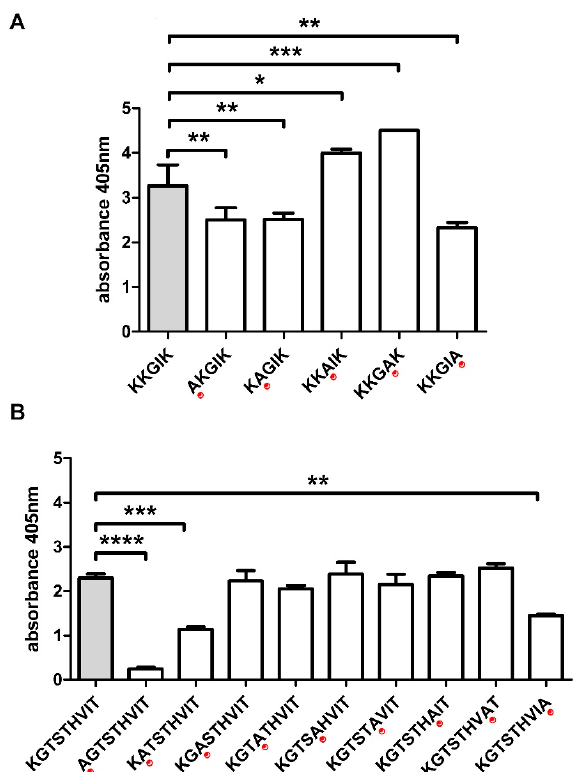
Figure 5. Characteristic of E4 and E8 functional epitopes. ( A ) presents “alanine walk” performed for 131 KKGIK 135 . ( B ) presents “alanine walk” performed for 184 KGTSTHVIT 192 . ELISA was repeated at least three times with the use of CDI patients’ sera (dilution 1:1000), detected with anti-human IgG secondary antibodies conjugated with AP, and colorimetric reaction was developed with AP Yellow Substrate. Data are shown with mean and ± SD. 1-way ANOVA and Dunnett’s multiple comparisons test were performed and significant differences were calculated (**** p ≤ 0.0001, *** p ≤ 0.001, ** p ≤ 0.01, * p ≤ 0.05).